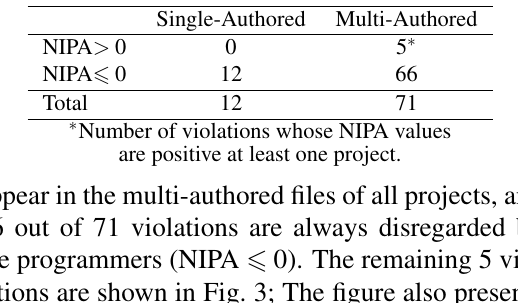
Table 9. Number of violations common to all projects.